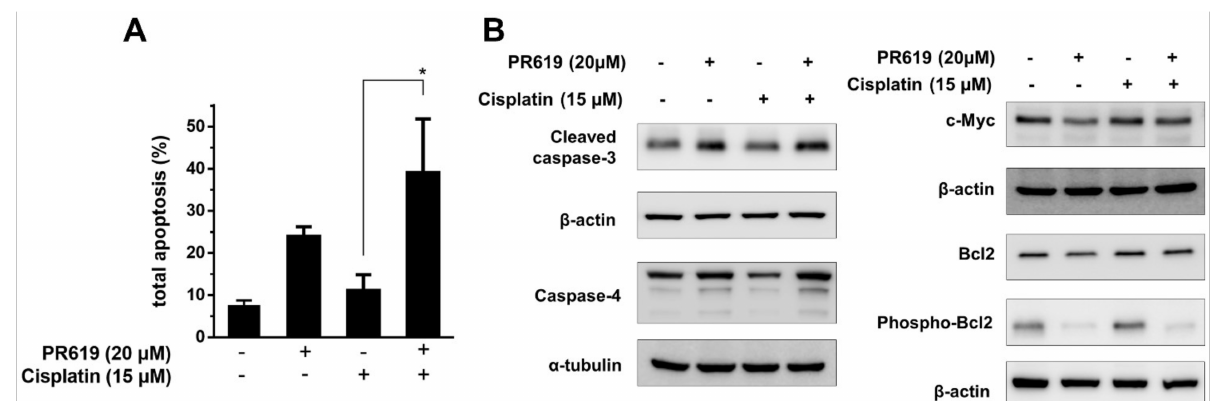
Figure 4. The antitumor effects of cisplatin in T24/R cells are enhanced by PR-619. The alleviation of cisplatin resistance was associated with the concurrent suppression of c-Myc expression. ( A ) Cells were exposed to cisplatin (15 µ M) or PR-619 (20 µ M) alone or in combination for 48 h. Apoptotic cells were analyzed using FACS with propidium iodide and Annexin V-FITC staining. ( B ) T24/R cells were treated with cisplatin (15 µ M) or PR-619 (20 µ M) alone or in combination for 48 h. Cell lysates were subjected to Western blotting analysis to detect cleaved caspase-3, c-Myc, Bcl2, and phospho-Bcl2. Values from the quantitative analyses of apoptosis are presented as the means ± standard deviation; * p < 0.05 represents a significant difference between the indicated groups.